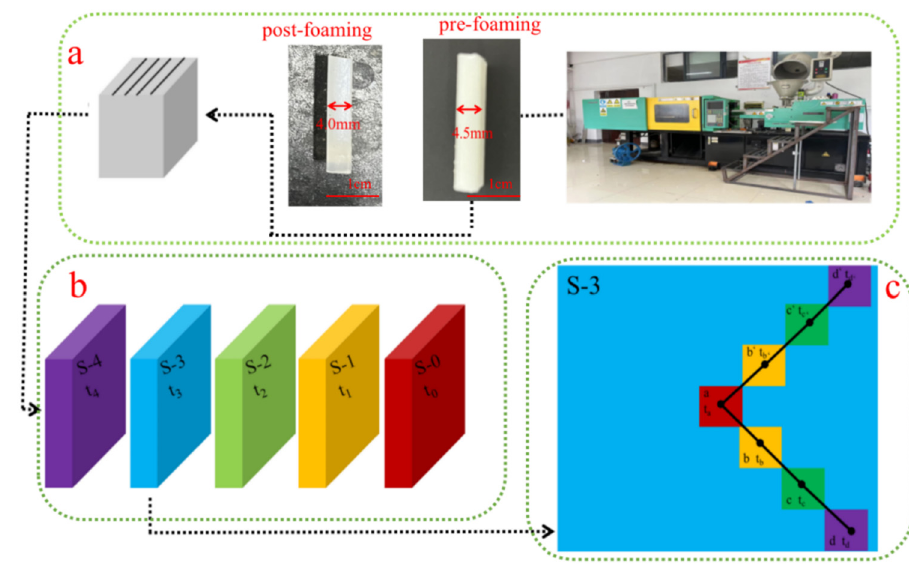
Figure 1: Schematic diagram of slices ( a ) , di ff erent isothermal planes ( b ) , and ( c ) di ff erent regions of the same isothermal